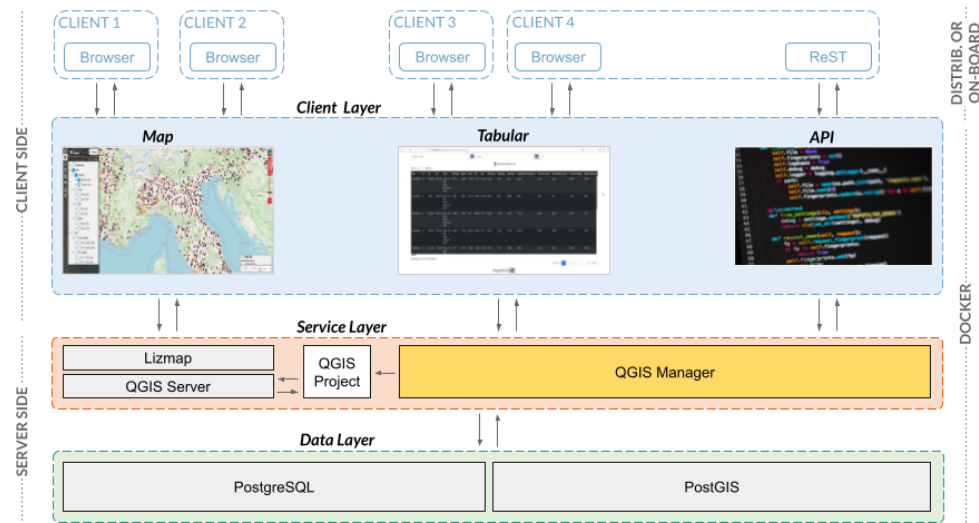
Figure 1. Architecture of the software. Clients can interact with the system through the Map, the Tabular, or the RESTful API. Our class QGISManager furnishes all the functions to perform CRUD operations on the platform